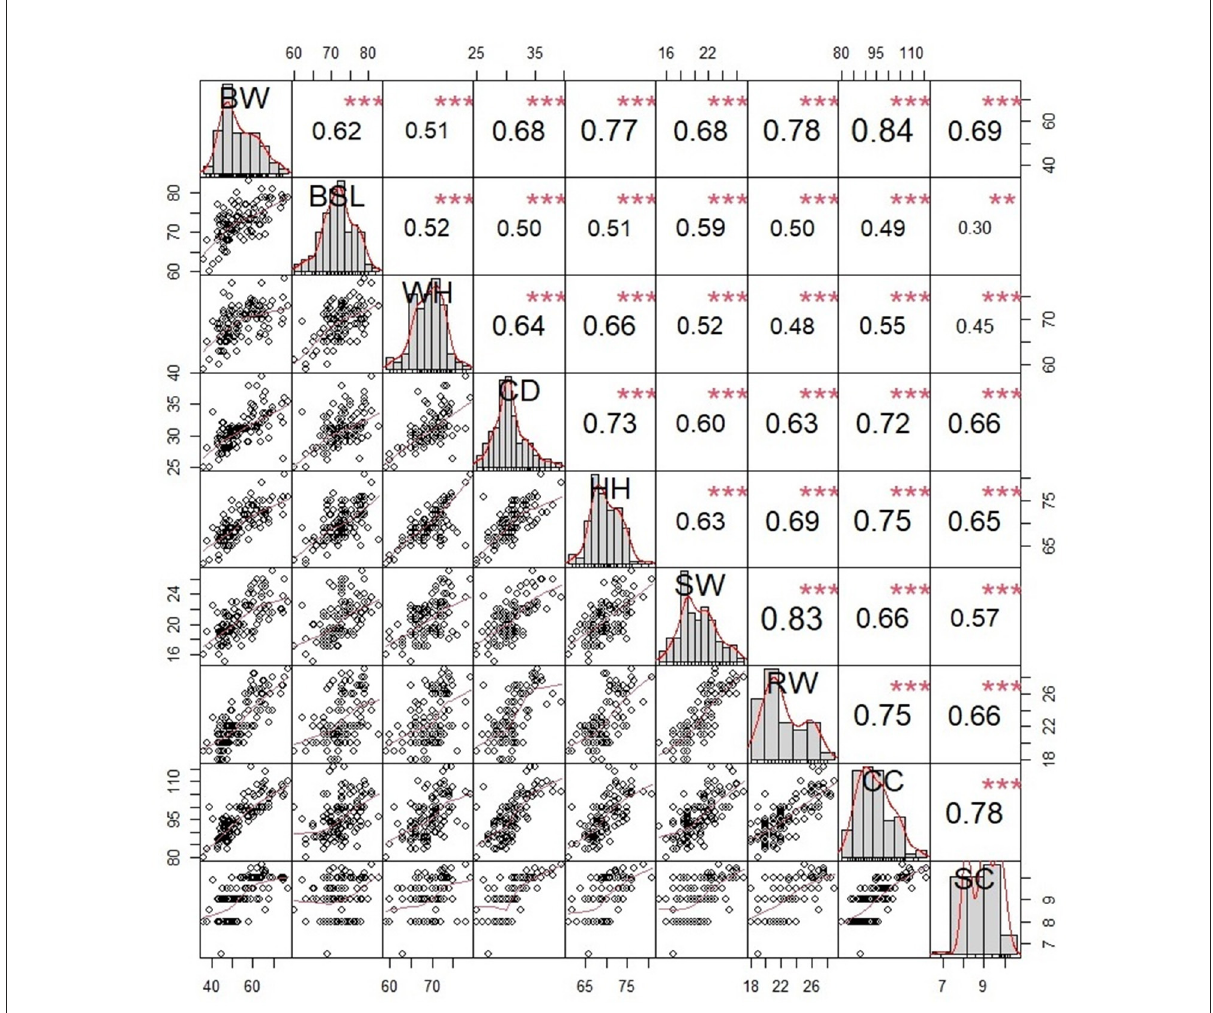
FIGURE4 Analysis diagram of the dam’s Spearman correlation. Scatter plots are shown in the lower left corner, correlation-significance plots between traits are shown in the upper right corner, and the data distribution map is shown in the middle. BW, body weight; HW, height at wither; BSL, body slanting length; CD, chest depth; CC, chest circumference; SC, shank circumference; HH, hip height; SW, shoulder width; RW, pump width. *p < 0.05, **p < 0.01, ***p <